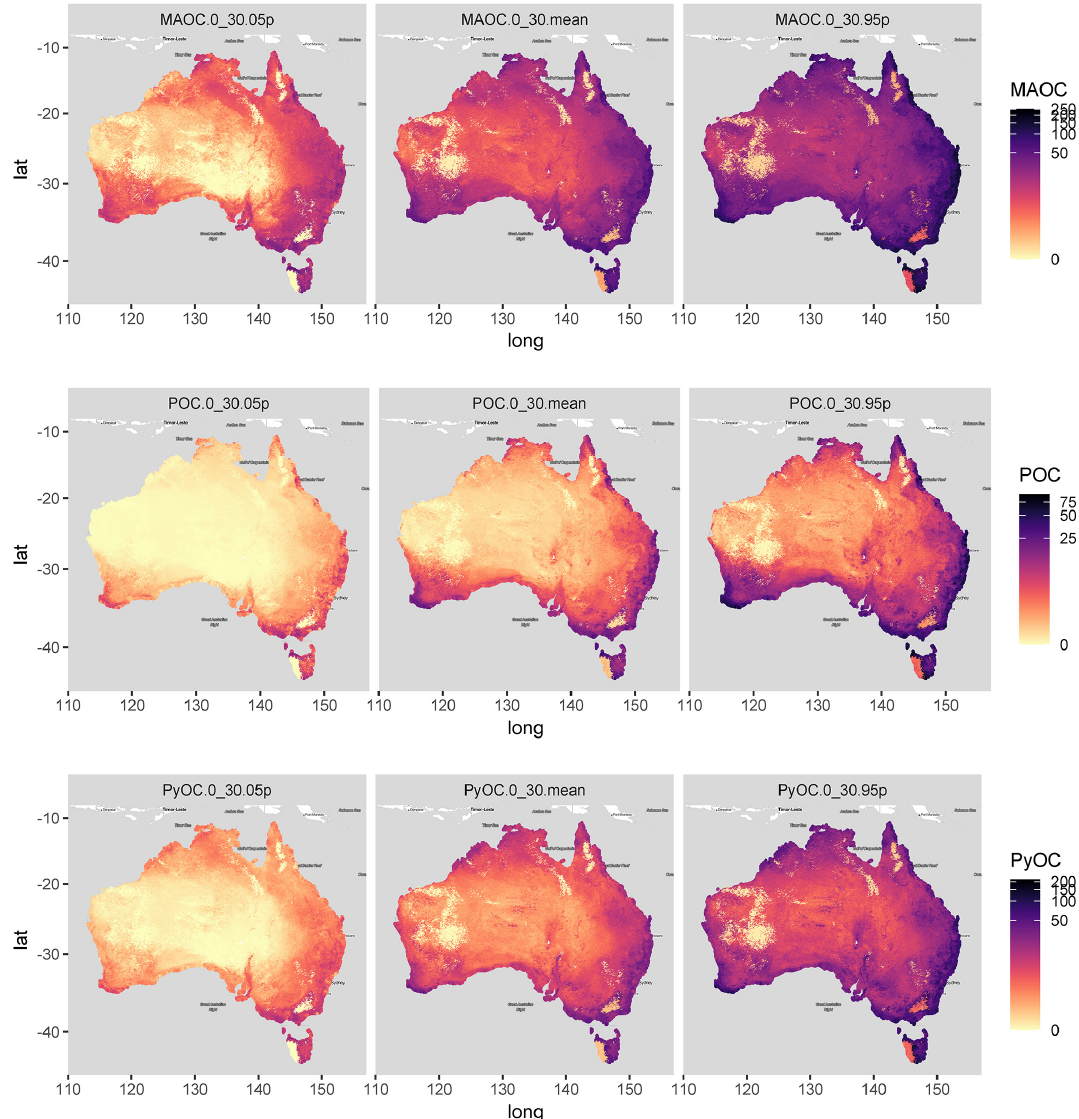
Figure 9. Uncertainty of SOC fraction stocks (MgCha − 1 ) for 0–30cm calculated with 500 simulations in a sub-set of 98400